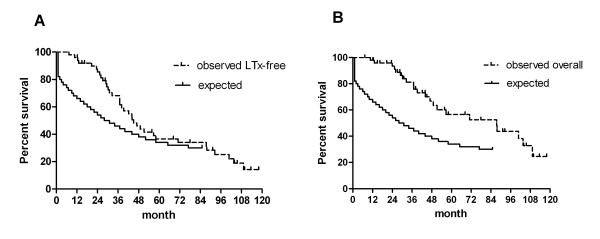
Kaplan-Meier curves showing the expected survival in comparison to the observed LuTx-free (A) and observed overall (LuTx censored) (B) survival from the time of diagnosis. Patients at risk were n = 50, n = 47, n = 41, n = 32, n = 21, n = 16 and n = 14 at diagnosis, 12, 24, 36, 48, 60 and 72 months after diagnosis (observed survival). Level of significance: LuTx-free survival vs. expected survival: p = 0.15. Overall survival vs. expected survival: p < 0.01. |: censored patients.